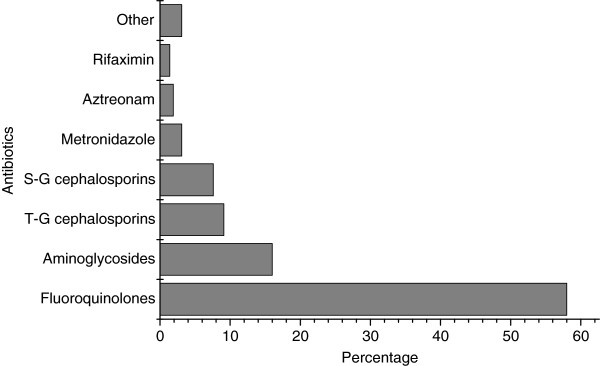
Antibiotics prescribed by treating physicians. T-G cephalosporins: third-generation cephalosporins, S-G cephalosporins: second-generation cephalosporins.